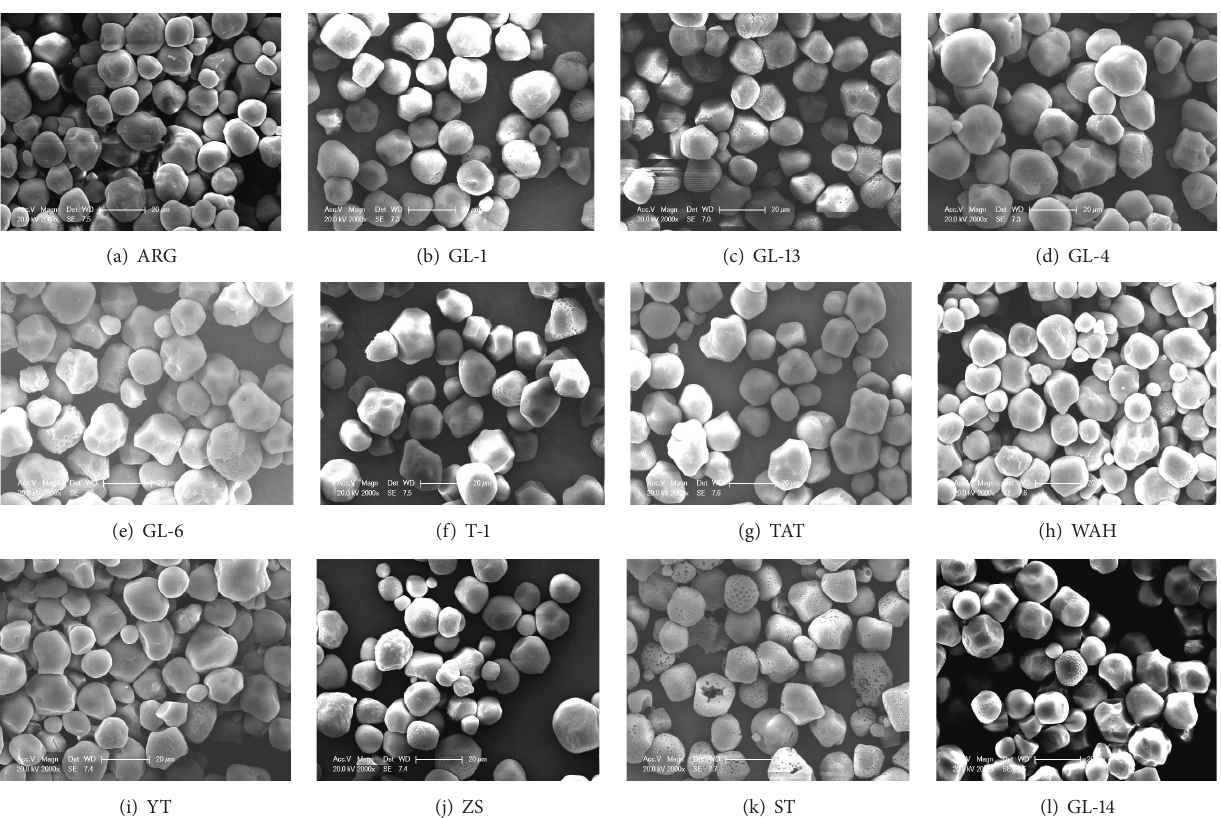
Figure 6: SEM images (2000x) of starch granules from different sweet and grain